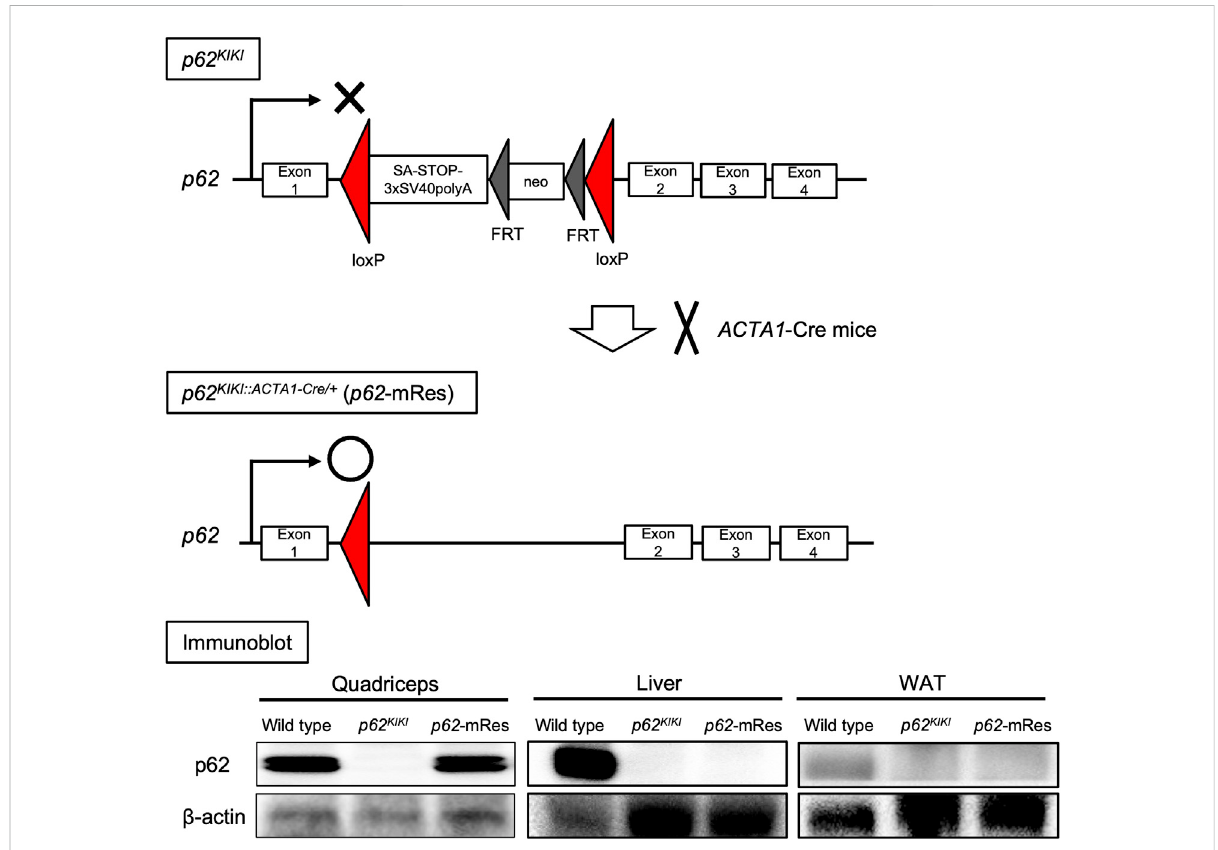
Generationofmuscle-speci fi c p62 generescuemice.Schematicdiagramofthedesignofthe p62 knock-ingene( p62 KIKI )andtheprocedurefor generating muscle-speci fi c p62 gene rescue mice ( p62 -mRes). p62 -mRes mice were generated by crossing with human alpha-skeletal actin ( ACTA1 )-Cre mice. p62 gene rescue in muscle was con fi rmed by immunoblotting of quadriceps , liver, and white adipose tissue